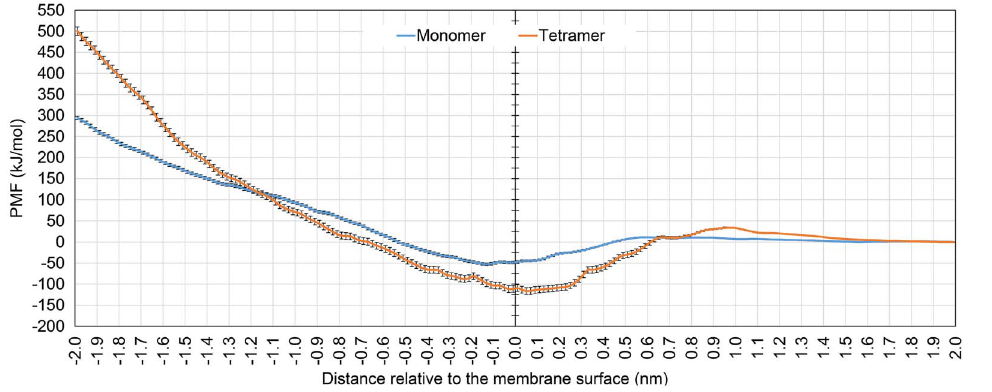
Figure 4. Potential of kB1 to penetrate the membrane. Mean force potentials for monomeric (blue line) and tetrameric (orange line) kB1 transferring from water (2.0 nm) across the membrane surface (0.0 nm) to the COM of the membrane ( 2 2.0 nm) are shown. Error bars were estimated using bootstrap